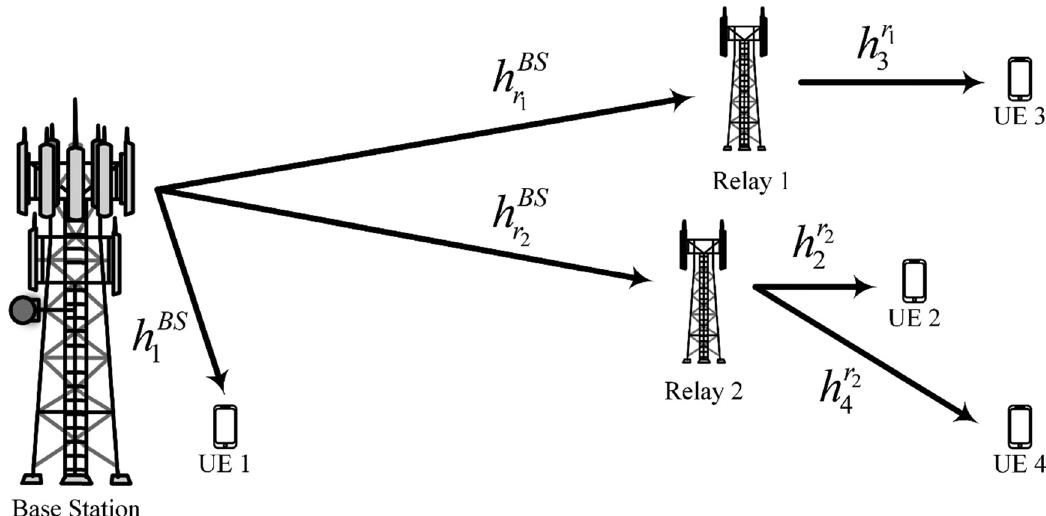
Figure 2: System model